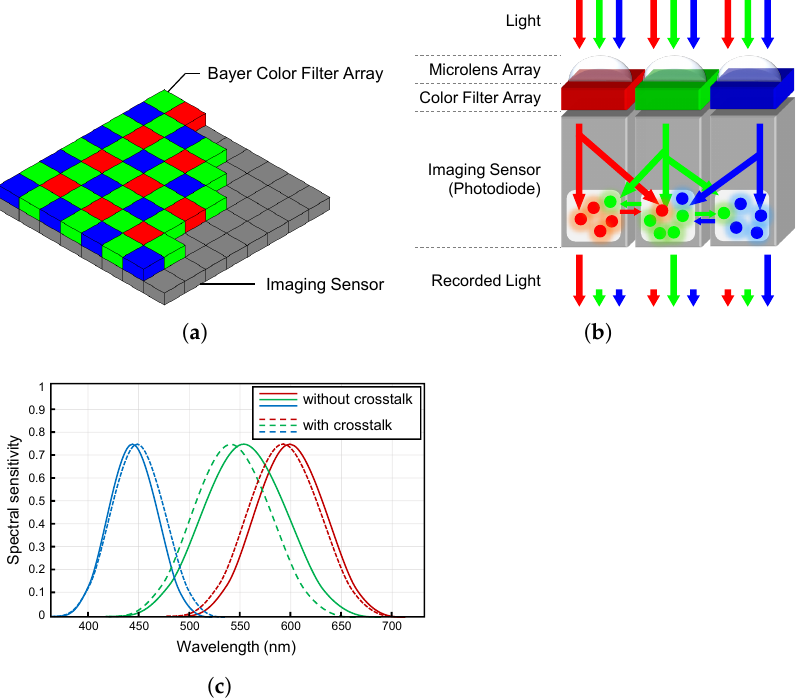
Figure 2. Bayer CFA and characteristics of crosstalk phenomenon: ( a ) Bayer CFA structure. The Bayer CFA consists of three filters for respective R, G, and B channels. ( b ) Schematic image of crosstalk inside the imaging sensor. ( c ) Example of the spectral sensitivity of the camera imaging system in a crosstalk-free condition (solid lines) and in a crosstalk condition (dashed lines). The spectral sensitivity shift is caused by crosstalk inside the imaging